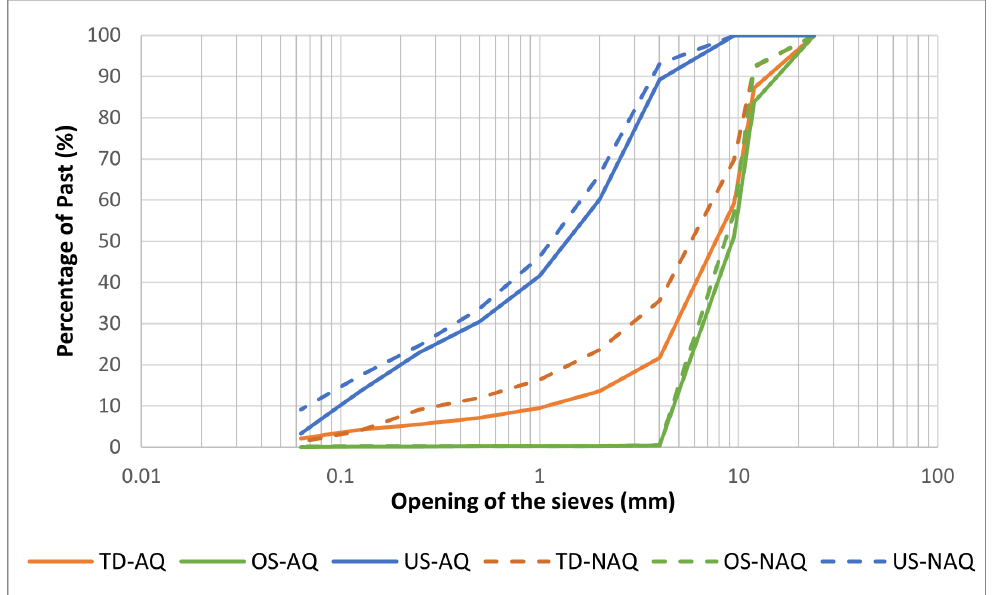
Figure 6. Percentage curves of passes according to the opening of the sieves of all the samples.